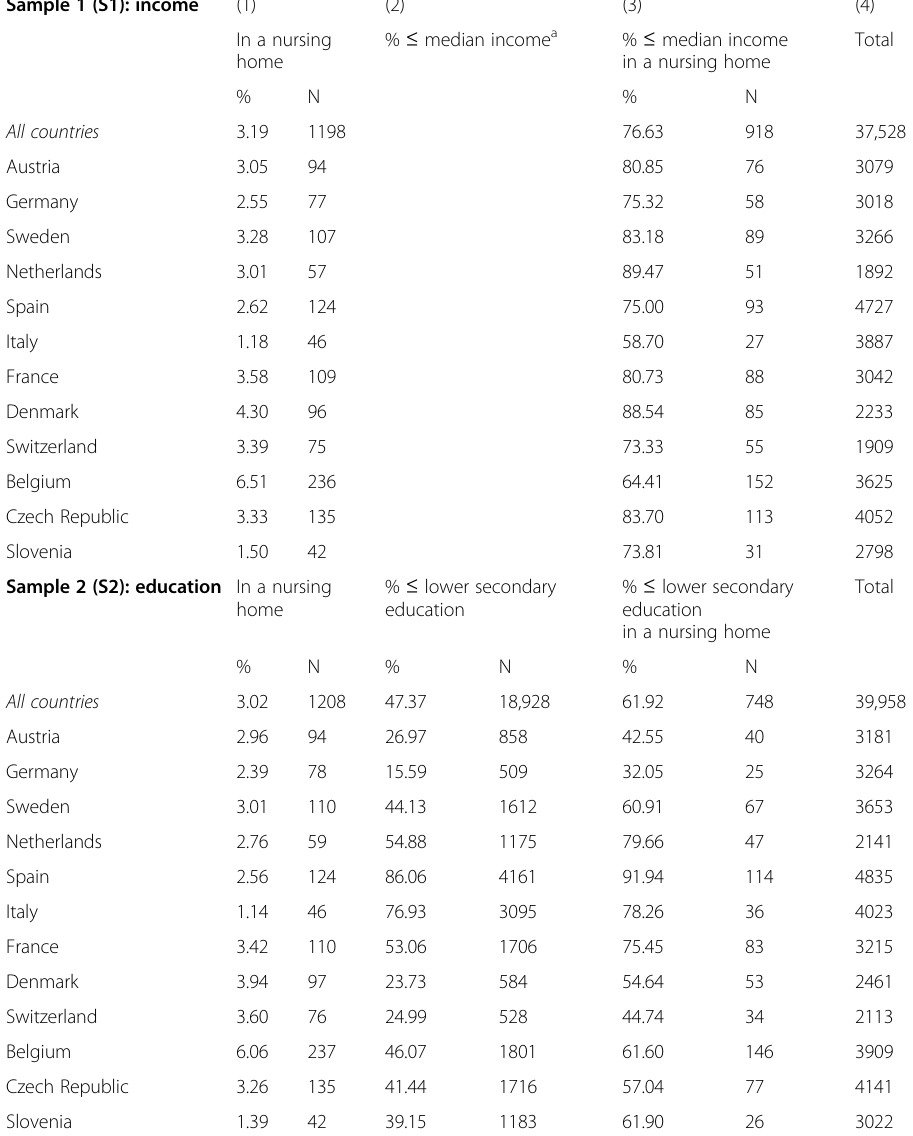
Table 1 Descriptive statistics by country for population aged 65 or more Sample 1 (S1):